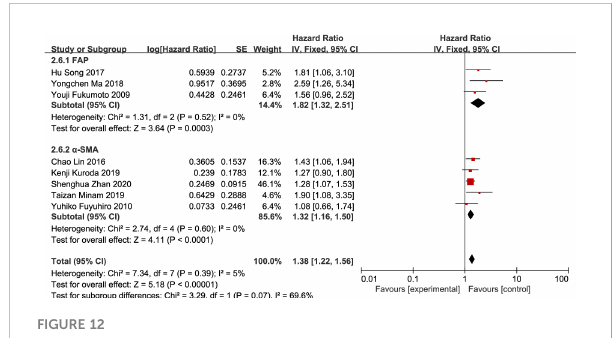
FIGURE 12 Subgroup analysis of high expression of CAFs and OS in gastric cancer. CAF, cancer-associated fi broblast; CI, con fi dence interval; OS overall survival; SE, standard